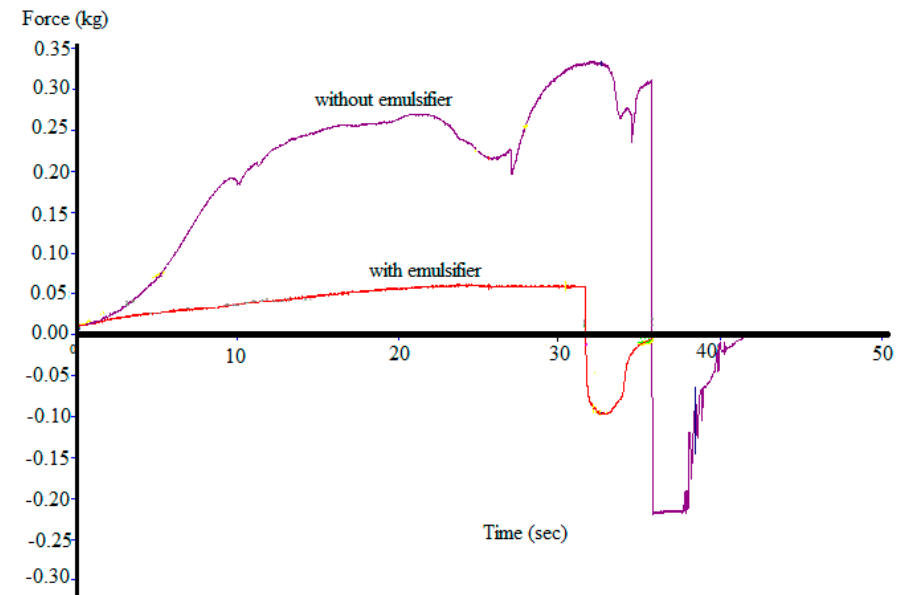
Figure 3. Changes in the texture profiles of palm olein-based diacylglycerol (POL-DAG) oil with 10 g/kg emulsifier and without emulsifier.